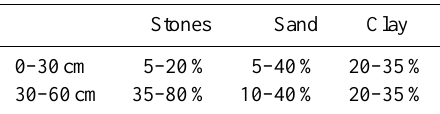
Table 3. Fractions of stones and sand for typical footslope soils at 0–30 and 30–60cm